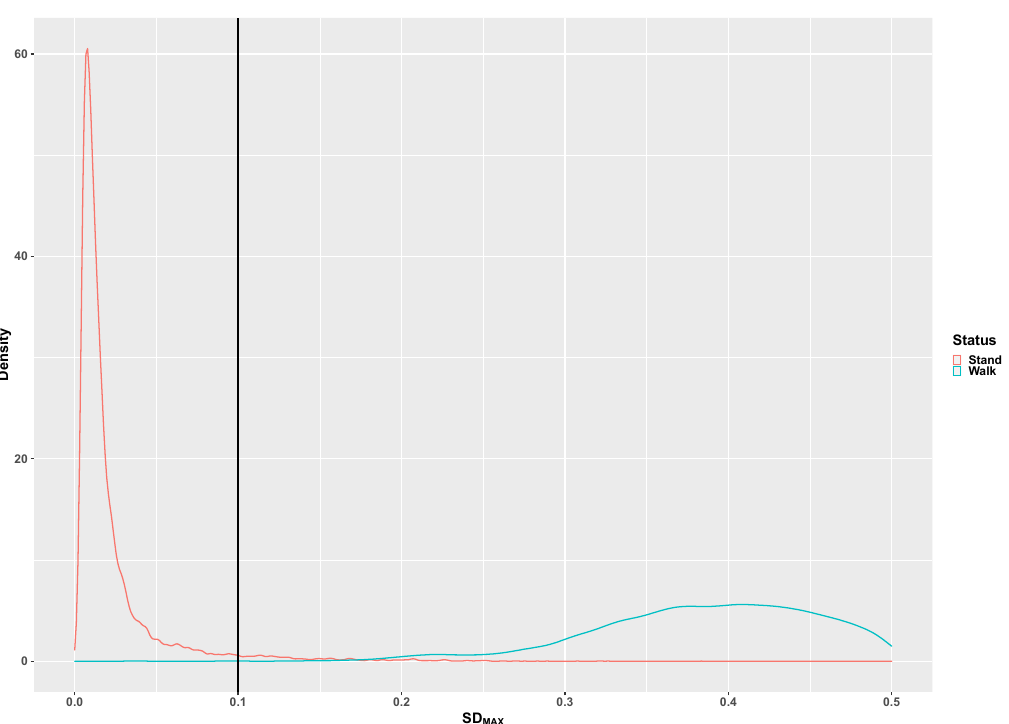
Figure 6. The pooled distribution of the SD MAX signal feature for standing (red curve) and walking (green curve) activities. The vertical line represents the original adult 0.1 g SD MAX threshold [16]. The SD x distribution for walking and running is presented in Figure 4. The SD x threshold for discriminating walking from running is 0.65G, which is lower than the 0.72G determined with Table 2. Activity type identification accuracy for sitting, standing, biking, walking and running for the three age groups—preschool, children and adolescents—using the validation data.